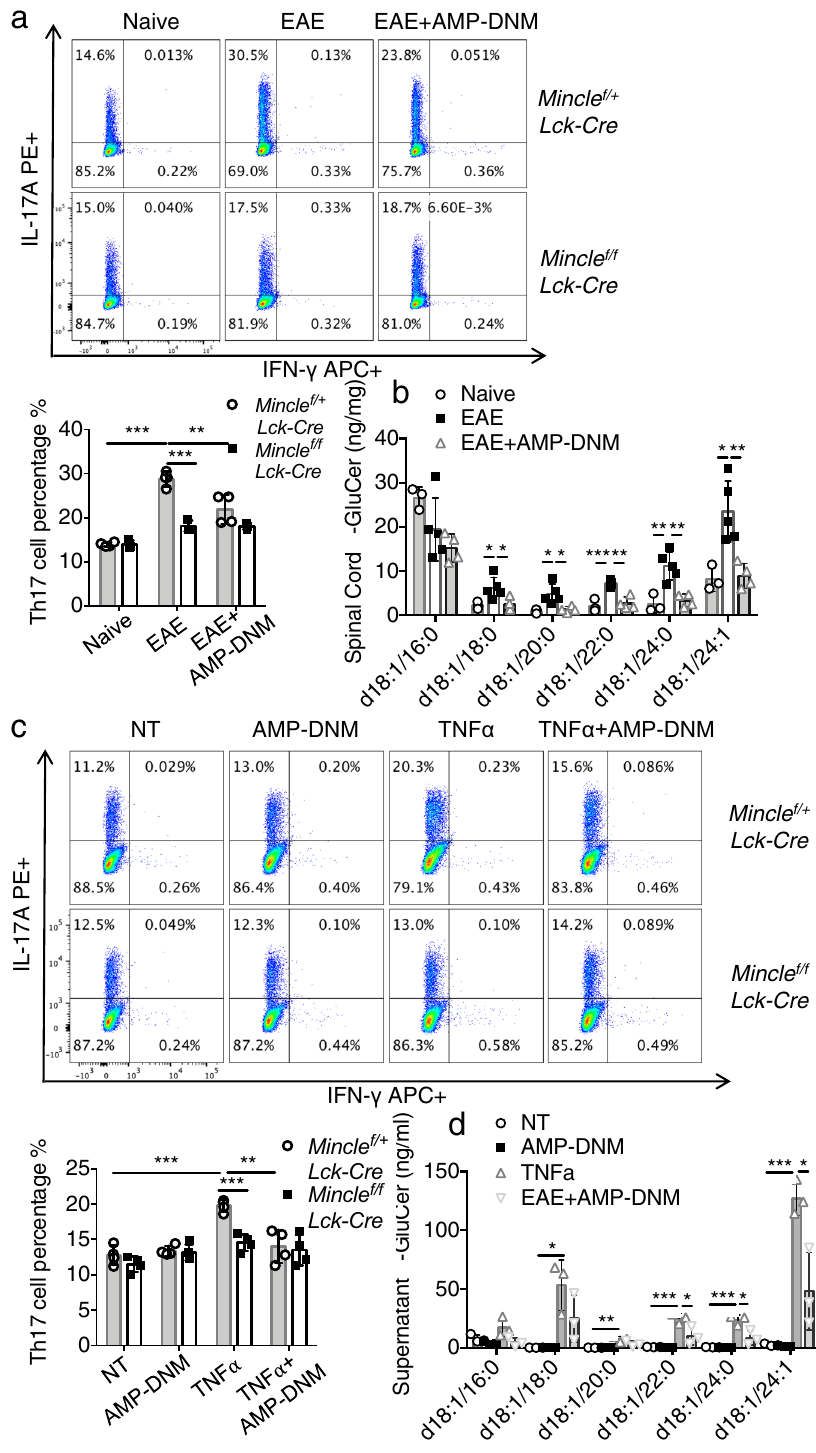
Fig. 7 Dying oligodendrocytes release β -glucosylceramide to activate TH17 through Mincle. a Flow cytometric analysis of IL-17A and IFN γ following T H 17 polarization with lipids extracted from spinal cord of naive, EAE or AMP-DNM treated EAE mice, n = 4 biological replicates. b Measurement of β -glucosylceramide from the spinal cord of naive, EAE and AMP-DNM treated EAE mice, n = 3, 5, 4 biological replicates. c Flow cytometric analysis of IL- 17A and IFN γ following T H 17 polarization with lipids extracted from supernatants of oligodendrocytes after the indicated treatments, n = 4 biological replicates. d Measurement of β -glucosylceramide from the oligodendrocyte culture medium under indicated stimulations for 12 h, n = 3 biological replicates. * P < 0.05, ** P < 0.01, *** P < 0.001 (Two sided student ’ s t test). Data are represented as mean ± SD. Exact P values for asterisks (from left to right): a < 0.0001 0.00004 0.0091 b 0.0376 0.0289 0.00047 0.0065 0.01178 0.0313 0.0193 0.00043 0.0030 0.0056 c 0.00013 0.00038